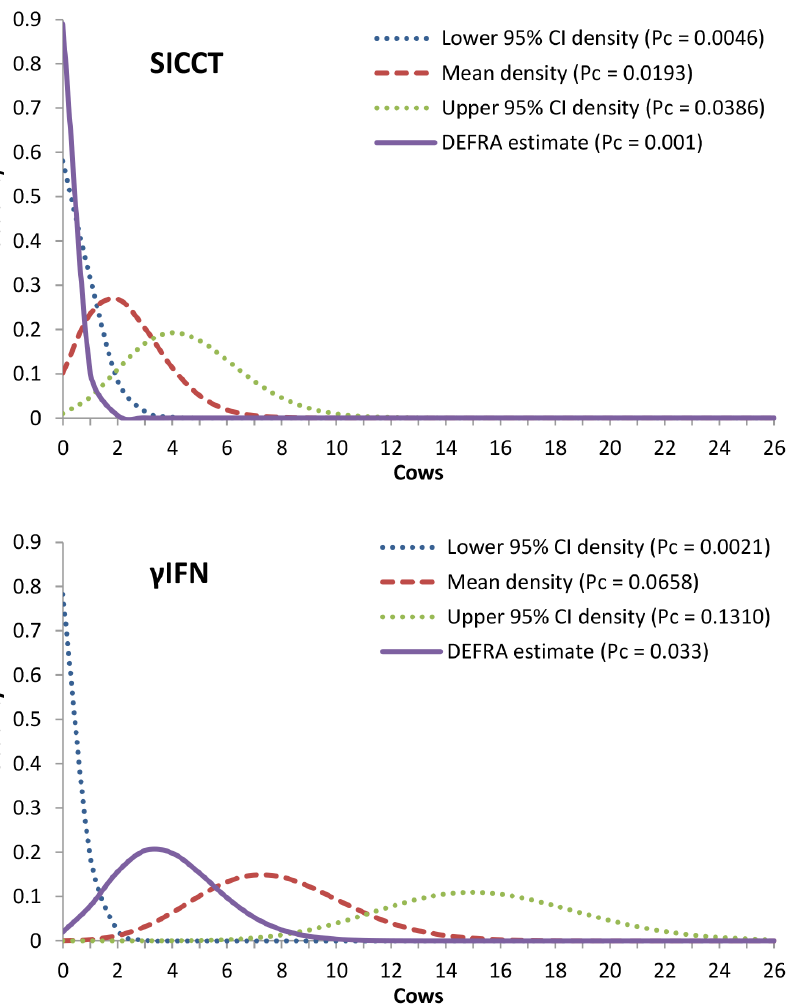
Figure 5. The number of cows predicted to test false positive in an average (117-cow) herd. Probability densities drawn for SICCT and c IFN with the probability of individual cows testing positive (Pc) equalling 1- Sp . The red probability density gives the animals based on the average values of Sp taken from the literature (95% confidence-limit densities also given), the purple density is based on the DEFRA-published Sp estimate (standard interpretation for SICCT).